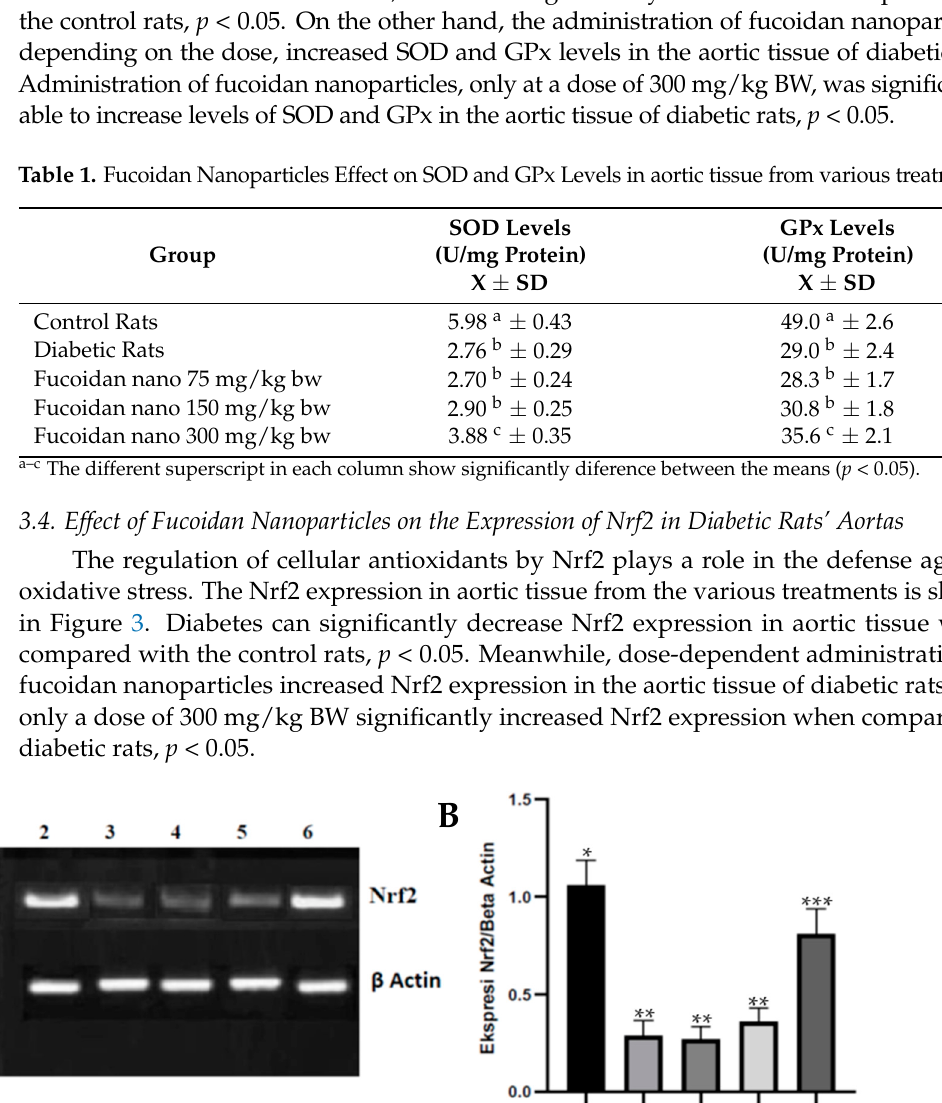
Table 2. Fucoidan nanoparticles effects on NO levels aortic tissue of various treatment. Group